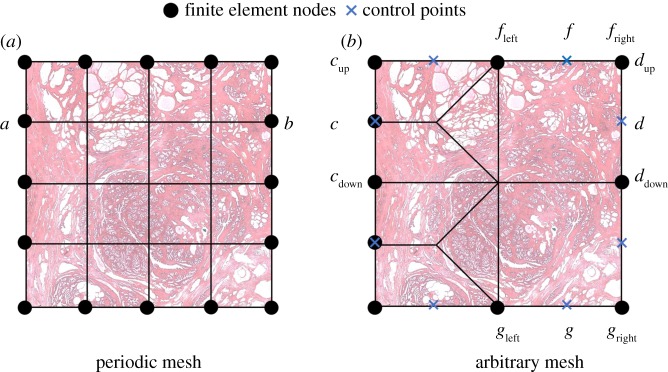
Schematic diagram of the proposed method of imposing PBC in a non-periodic mesh. (a) Example of a periodic mesh where nodes at all boundaries have a matching node at the opposite side. (b) A non-periodic mesh where some nodes (e.g. c) do not have a matching node at the opposite side. (Online version in colour.)